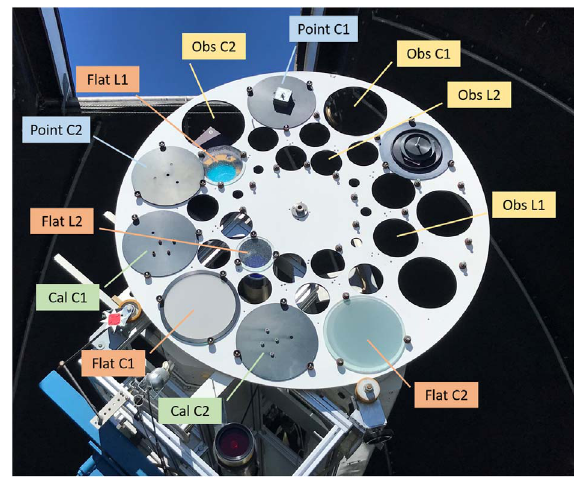
Fig. 8. CLIMSO ’ s front fi lter wheel with the functions of the used slots for pointing the Sun ( “ Point ” blue labels), observations ( “ Obs ” yellow labels), calibration ( “ Calib ” green labels) and fl at fi elds ( “ Flat ” orange labels).